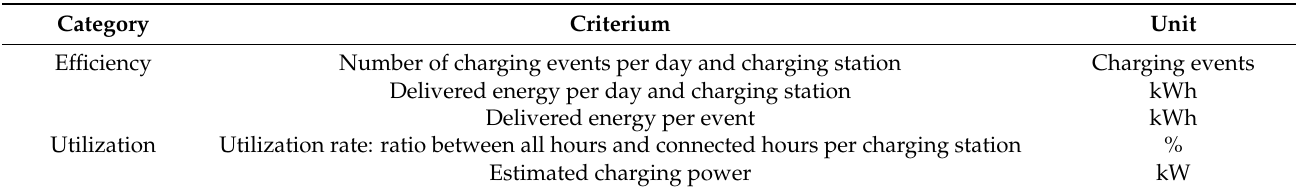
Table 1. Evaluation criteria for the utilization of public charging